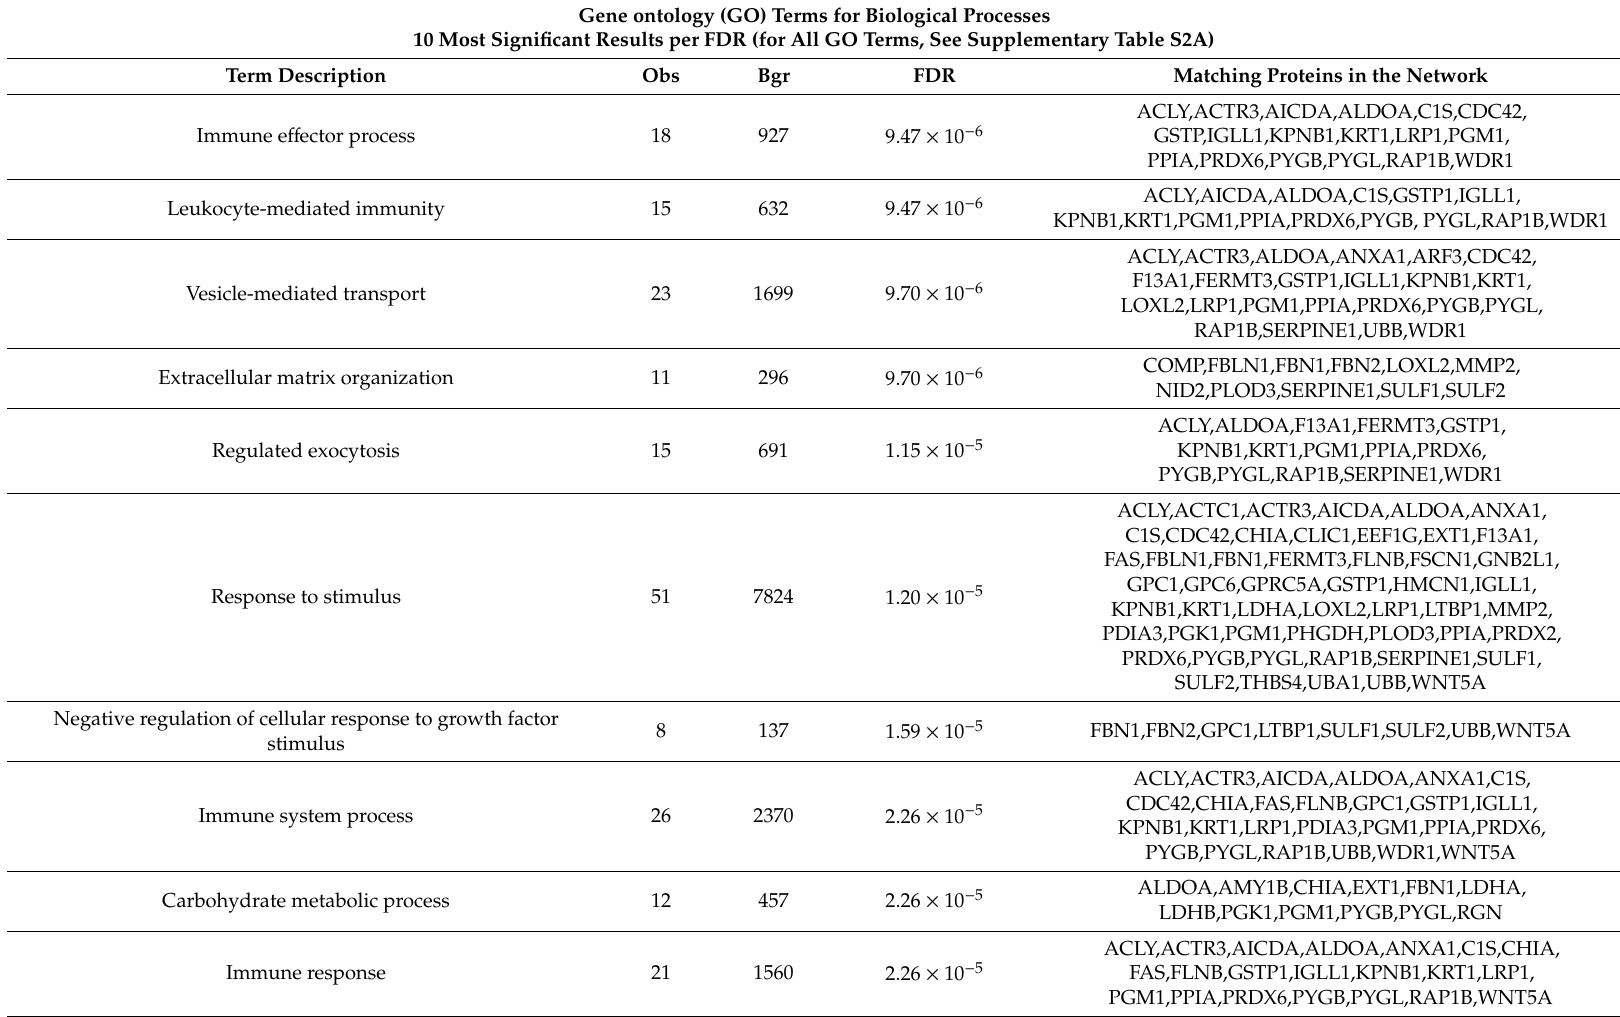
Table 6. Biological processes, KEGG pathways, and PMIDs for the EV surface unique proteins in the HIV + A β group for the HIV vs. HIV + A β comparison. Gene ontology (GO) Terms for Biological Processes 10 Most Significant Results per FDR (for All GO Terms, See Supplementary Table